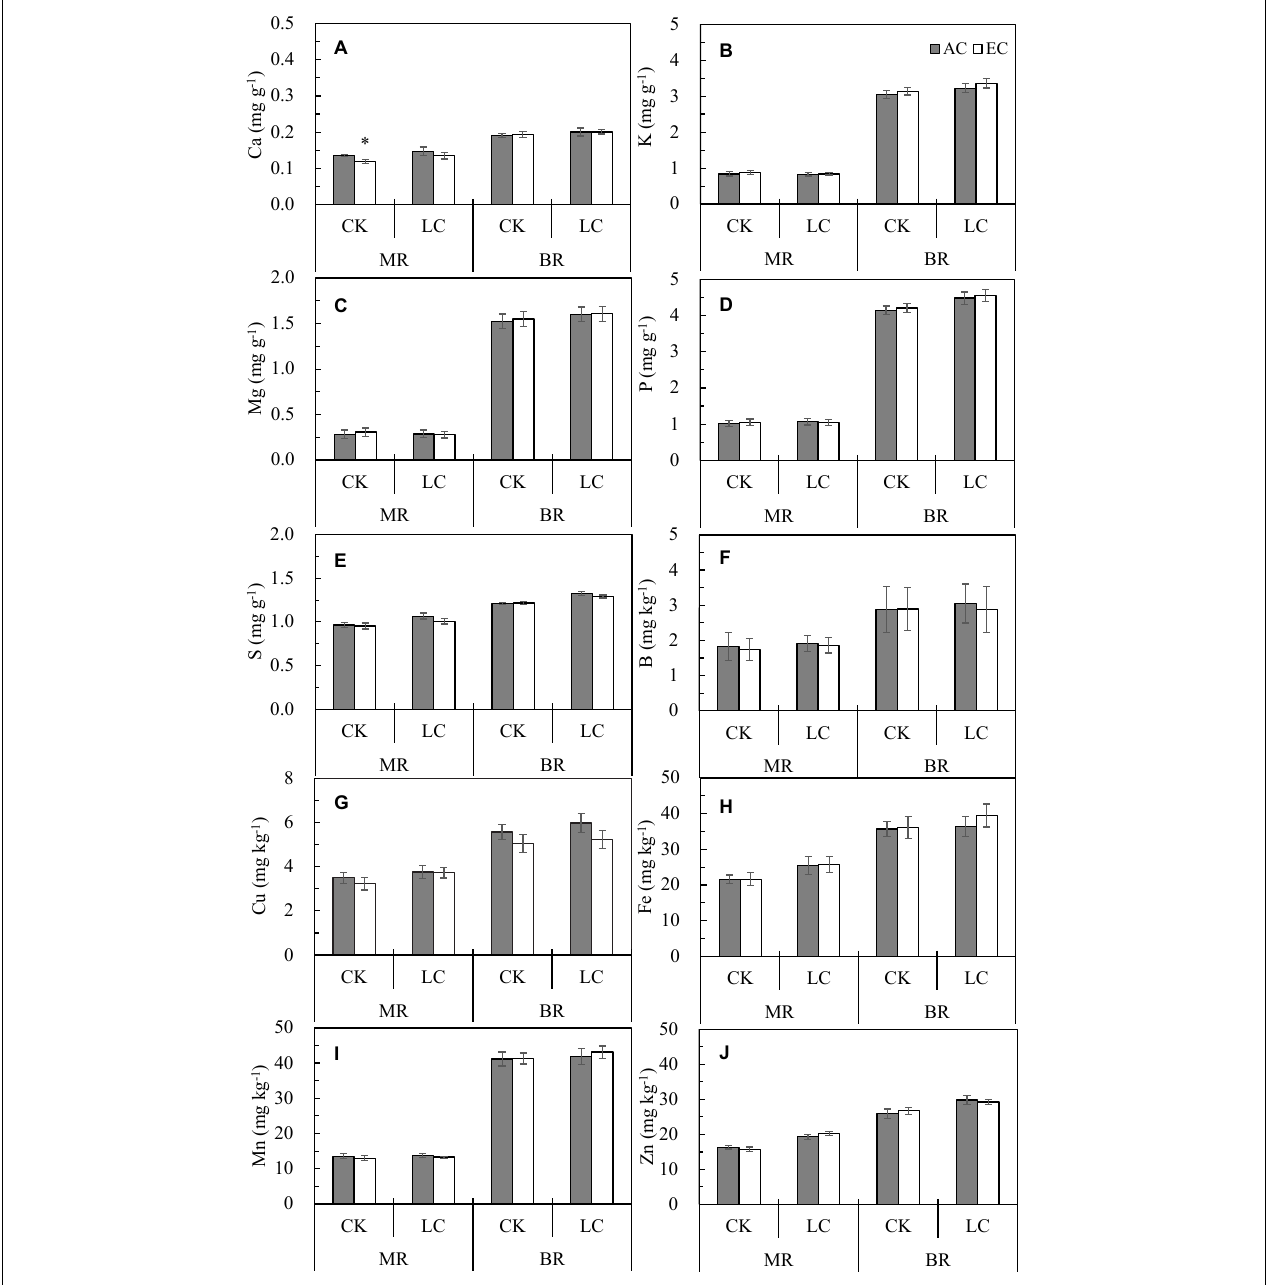
FIGURE 4 | The concentration of Ca (A) , K (B) , Mg (C) , P (D) , S (E) , B (F) , Cu (G) , Fe (H) , Mn (I) , Zn (J) in milled rice (MR) and brown rice (BR) of WYJ27 as affected by elevated CO 2 under CK (no leaf cutting) and LC (cutting off top three leaves) across three cropping seasons (2016–2018). Each bar in the figure represents the mean values across three plots for ambient CO 2 (AC, filled square) or elevated CO 2 (EC, AC + 200 ppm, unfilled square); vertical bars represent standard error ( n = 3). Statistically significant effects are indicated as ∗ P <